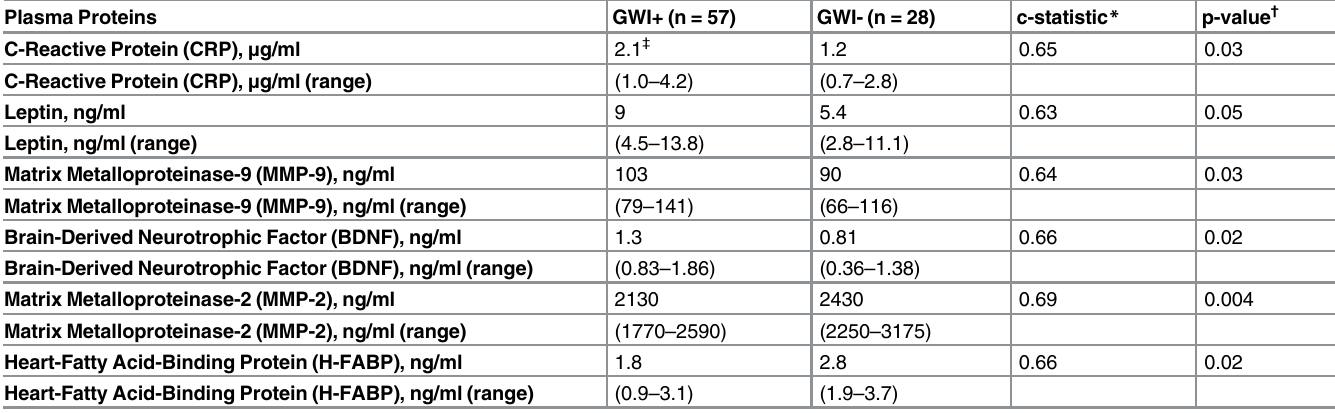
Table 4. Proteomic Analysis of Plasmas from GWI+ and GWI- Veterans. Plasma